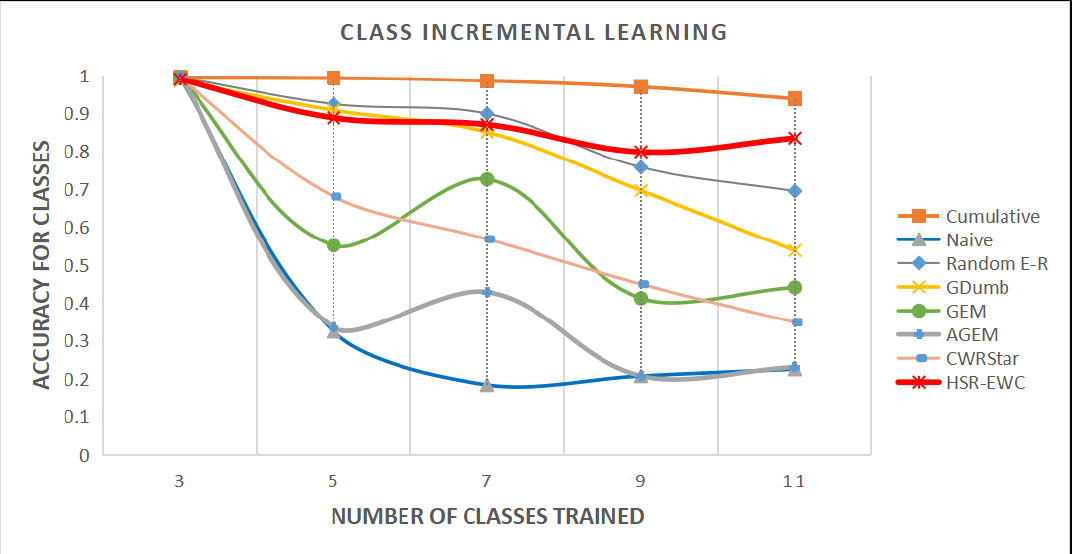
Figure 6. Accuracy on CoroTrans-learnt classes with different strategies.